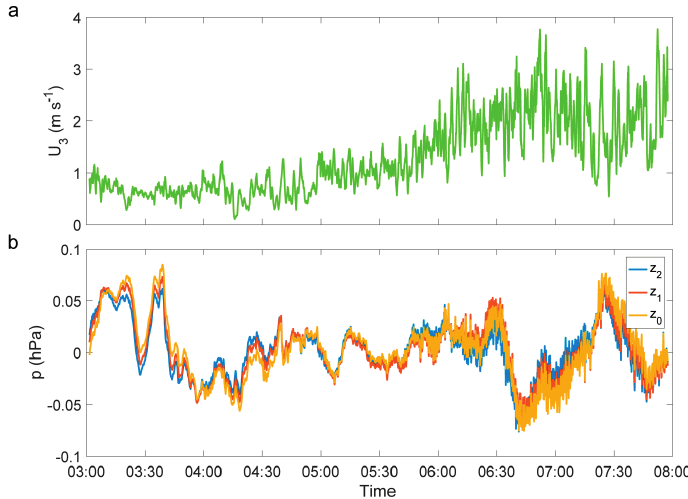
Figure 3. ( a ) Above-canopy wind speed ( (cid:1847) (cid:2871) ); and ( b ) the air pressure signals measured at heights (cid:1878) (cid:2870) ( (cid:1868) (cid:2870) ), (cid:1878) (cid:2869) ( (cid:1868) (cid:2869) ), and (cid:1878) (cid:2868) ( (cid:1868) (cid:2868) ) during the period 22 April 2016 03:00–08:00. The dependence of the air pressure amplitudes at (cid:1878) (cid:2870) ( (cid:1868)̂ (cid:2870) ) on above-canopy mean wind speed ( (cid:1847)(cid:3365) (cid:2871) ) was used to determine whether the amplitudes of the fluctuations in a frequency range change as a function of wind speed (Figure 4a). In addition, the correlation of the fluctuations between (cid:1868) (cid:2870) and (cid:1868) (cid:2869) , and (cid:1868) (cid:2869) and (cid:1868) (cid:2868) was determined by analysis of (cid:1844)((cid:1868) (cid:2870) , (cid:1868) (cid:2869) ) and (cid:1844)((cid:1868) (cid:2869) , (cid:1868) (cid:2868) ) with respect to (cid:1847)(cid:3365) (cid:2871)